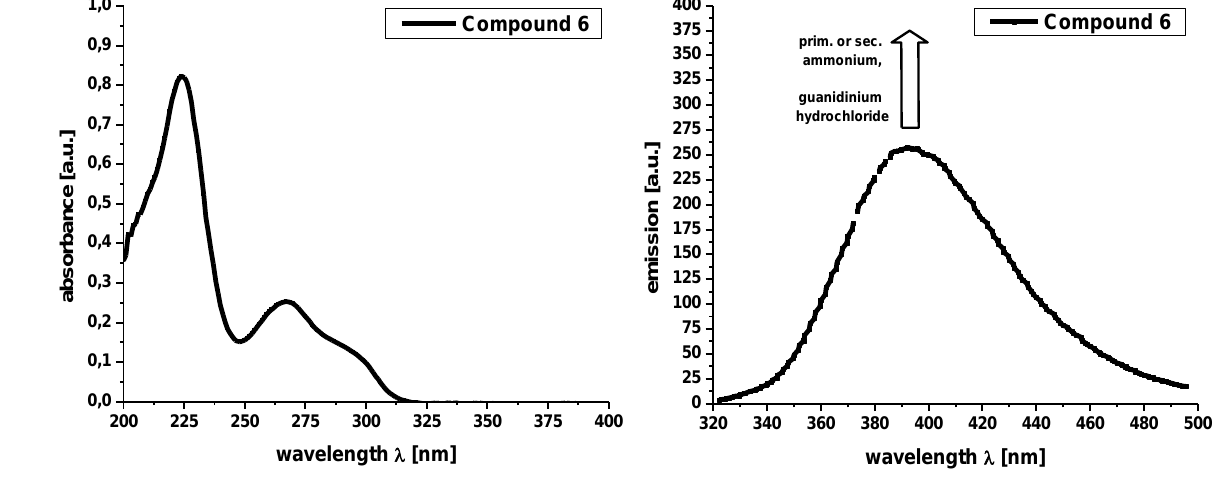
Figure 1. Absorption and emission spectra of compound 6 (c = 2.8 × 10 -5 mol/L) in methanol